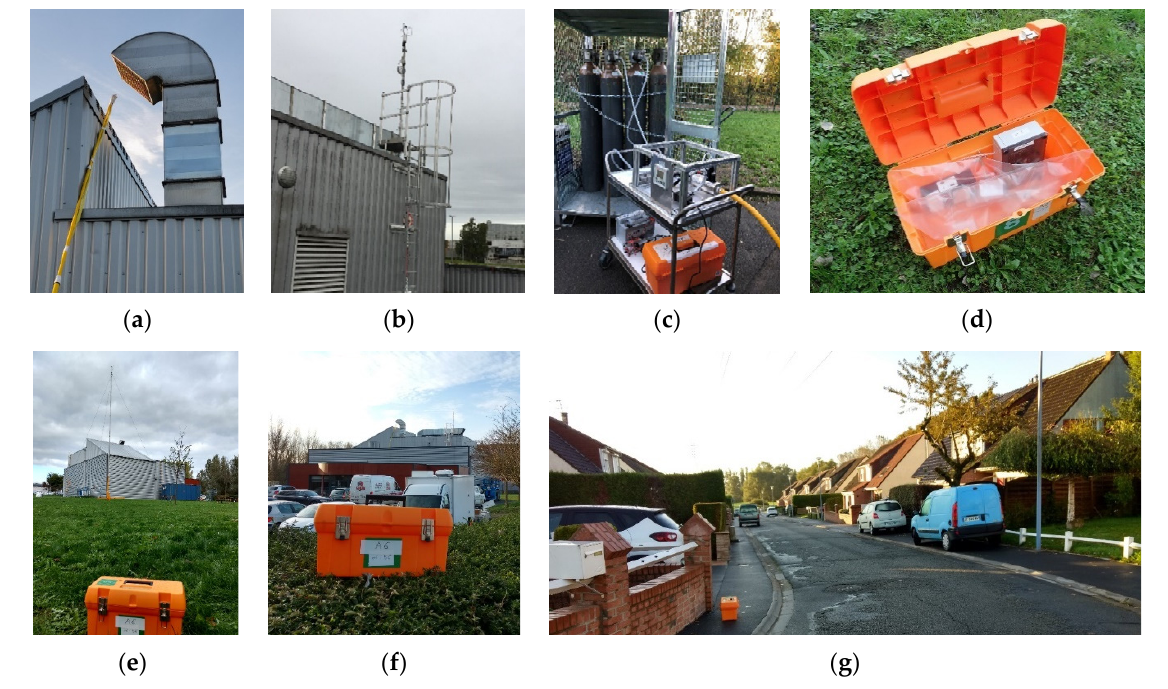
Figure 2. ( a ) Cyclotron discharge stack; ( b ) Young ultrasonic anemometer on the cyclotron roof; ( c ) helium discharge system; ( d ) Atmospheric sampler AS equipped with a sampling pump connected to a Tedlar bag and a flowmeter; ( e – g ) examples of AS locations at 40 m ( e , f ) and 150 m ( g ) from the discharge point.